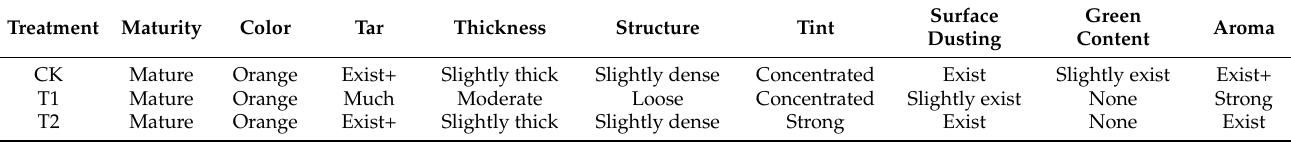
Table 5. Comparison of appearance quality of tobacco leaves after different